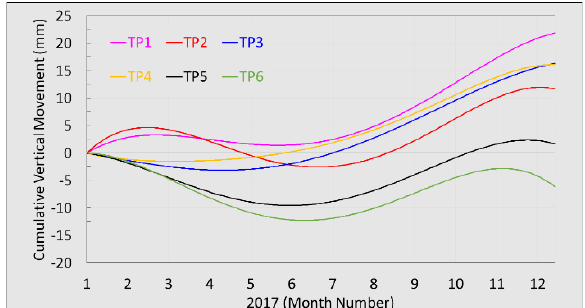
Figure 6. Cumulative vertical movement (mm) of target points (TP) 1 – 6 (Figure 3) in 2017 after fitting. Positive and negative, up and down movements, respectively.